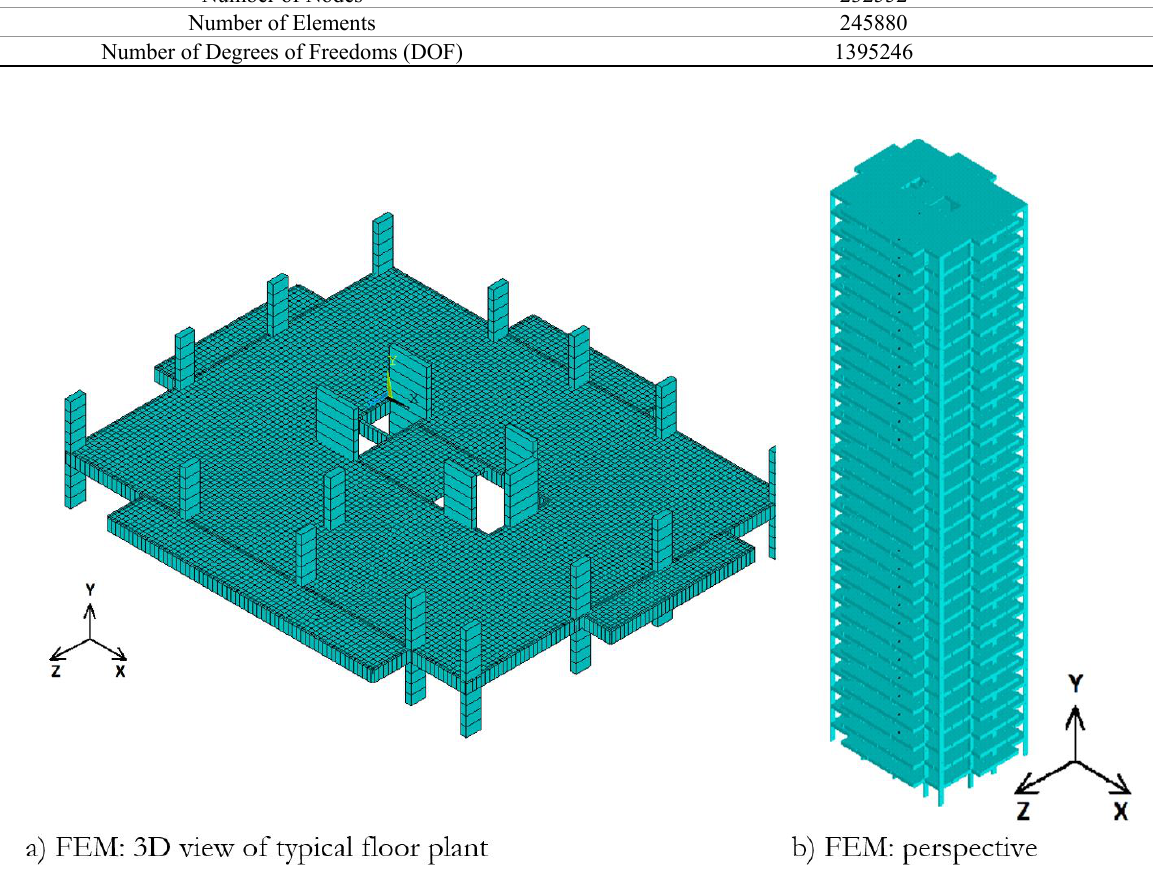
Figure 7. Finite element model of the investigated